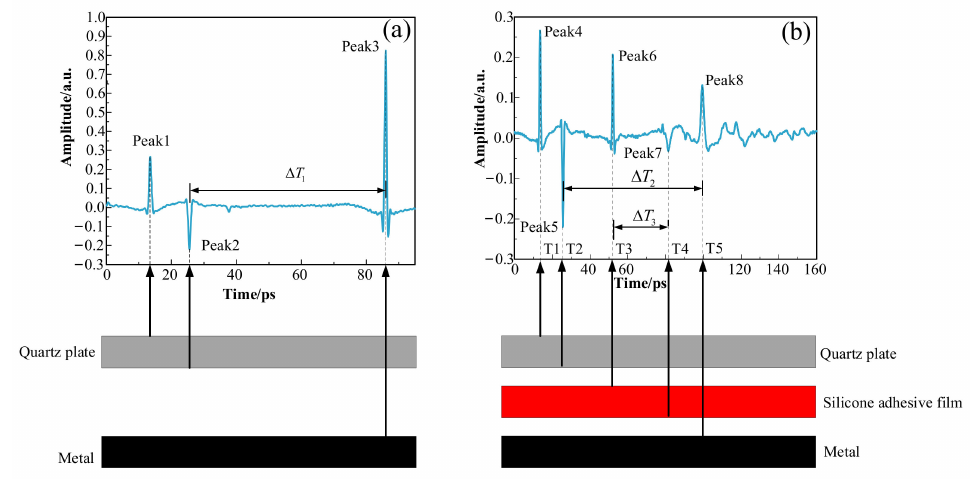
Figure 6. THz caliper thickness measurement principle.